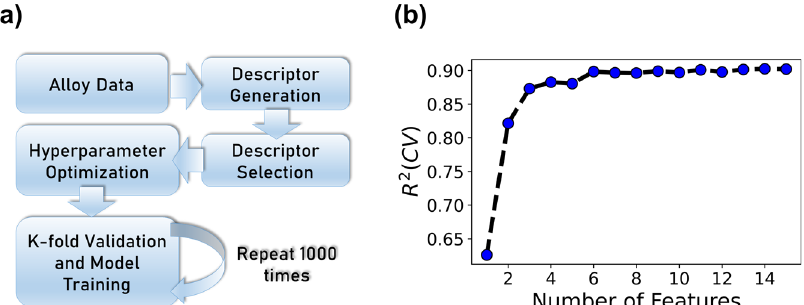
Fig. 8 Model training and feature selection process. a ML model development procedure followed in this work; b Changes in cross- validation coef fi cient as a function of number of descriptors. It shows there is no signi fi cant improvement beyond six (6)